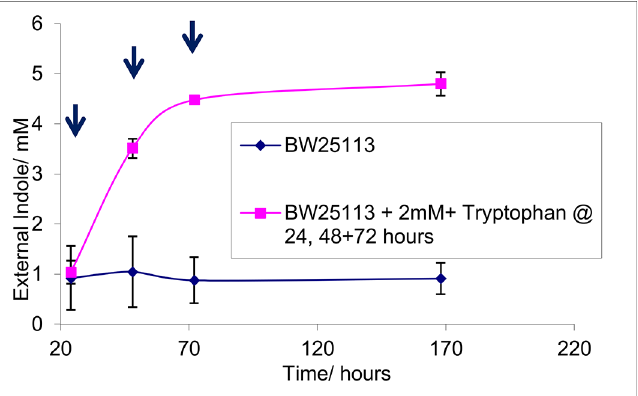
Fig 3. The addition of tryptophan to a stationary phase BW25113 culture leads to further indole synthesis. Stationary phase (24 hours) BW25113 cells were incubated with no additional tryptophan or 2 mM tryptophan added every subsequent 24 hours (arrows indicate times of addition). Samples were removed then centrifuged to remove cells. The supernatant was assayed for external indole using Kovacs assay. Data shown are the mean values ± standard deviation for three independent